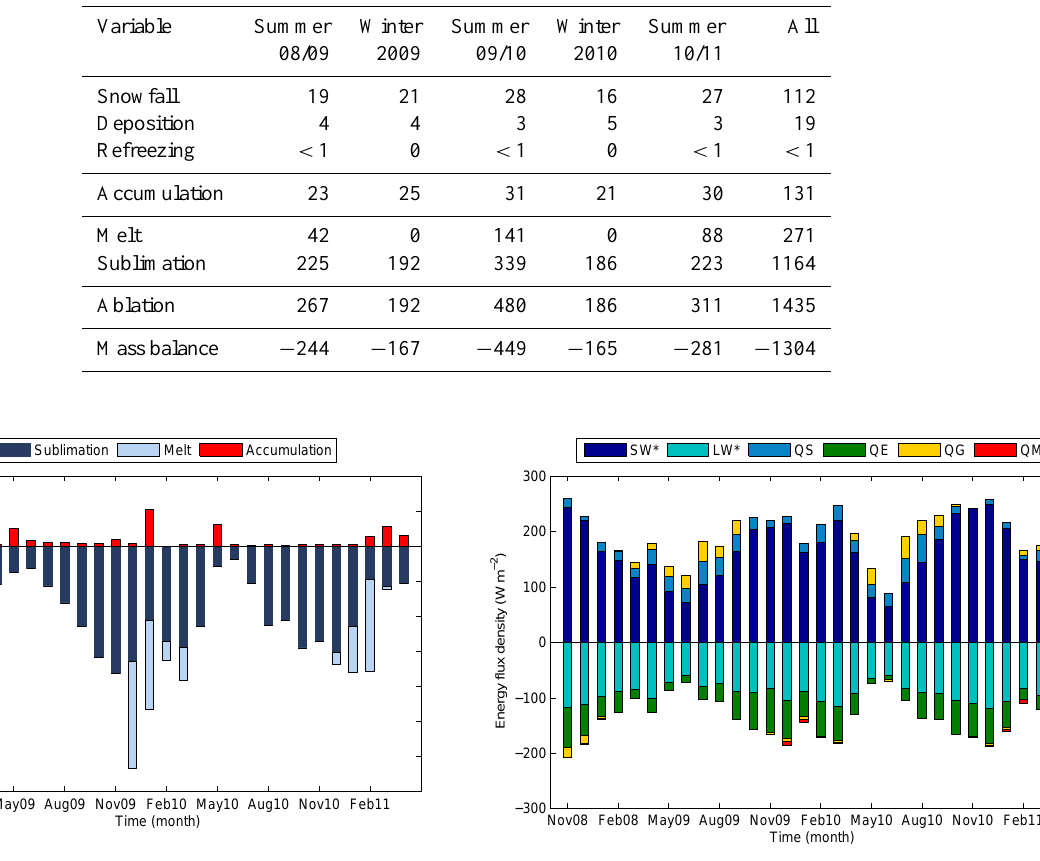
Fig. 4. Monthly totals of melt, sublimation and accumulation modelled at the G-AWS site for the period 9 October 2008– 30 April 2011. At the G-AWS, 1164mmw.e. of sublimation and 271mmw.e. of melt were calculated.